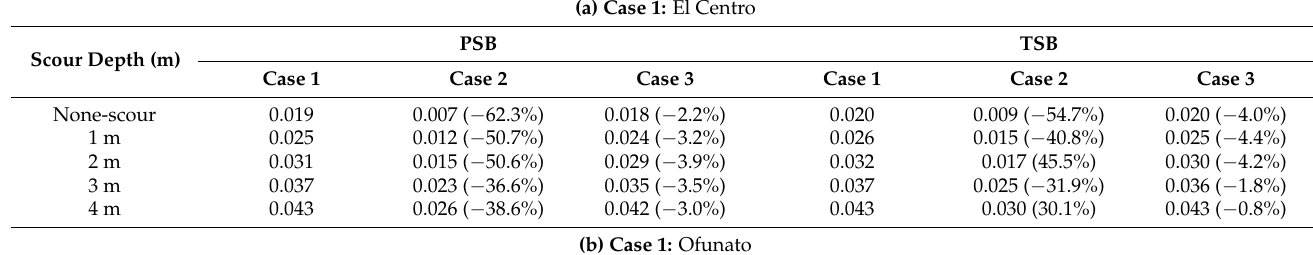
Table 9. Maximum top displacement of SB under different